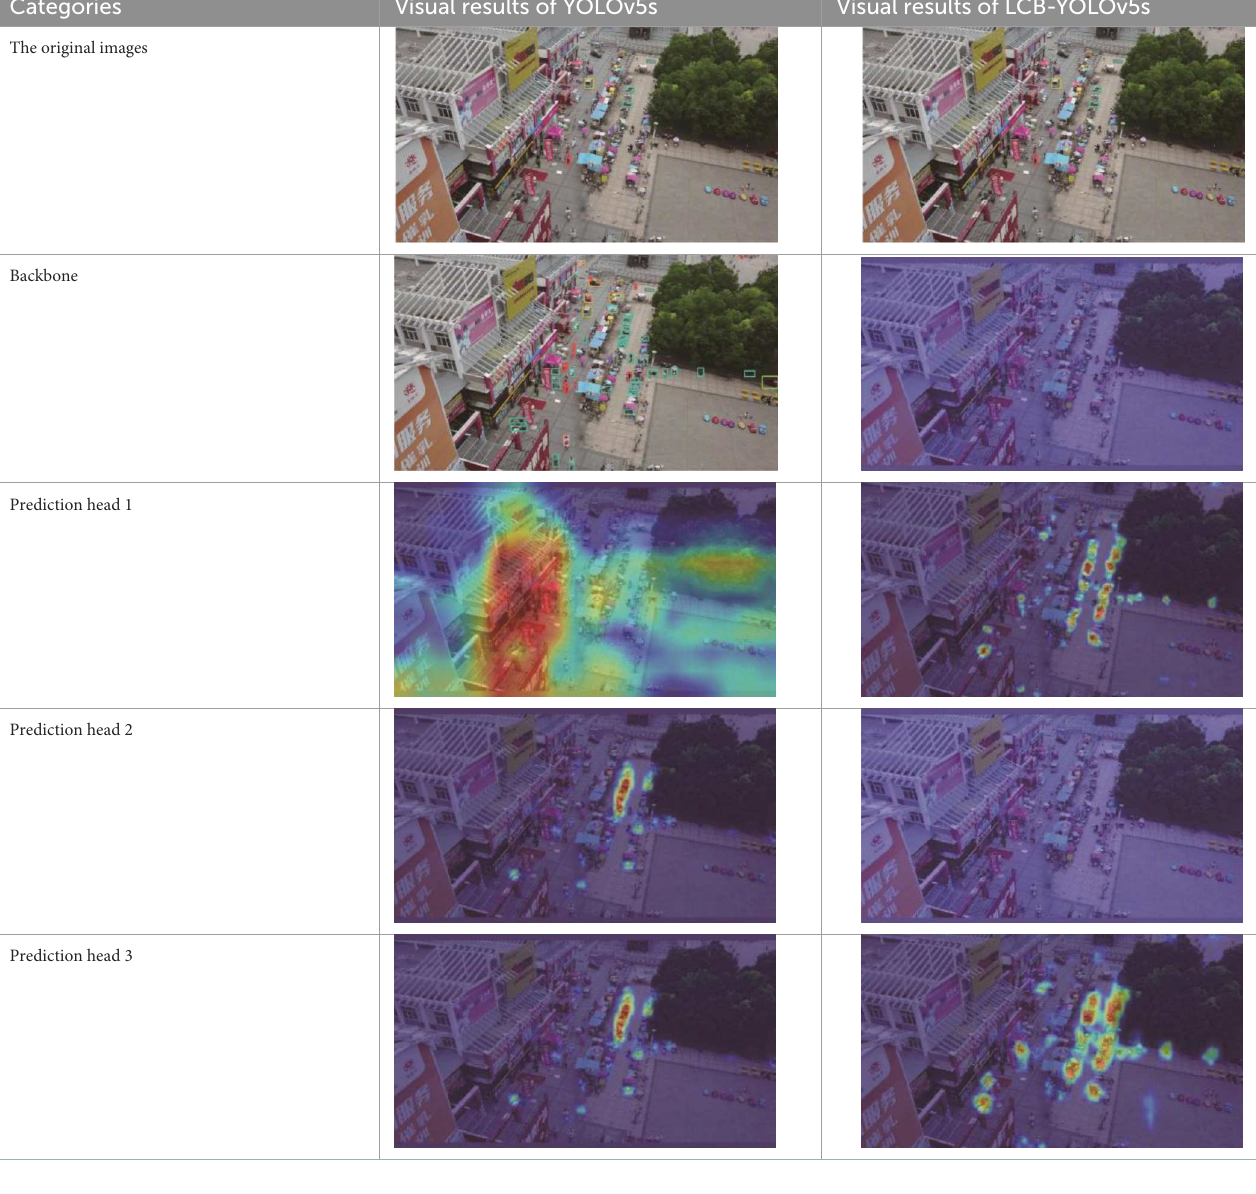
TABLE 6 Results of ablation